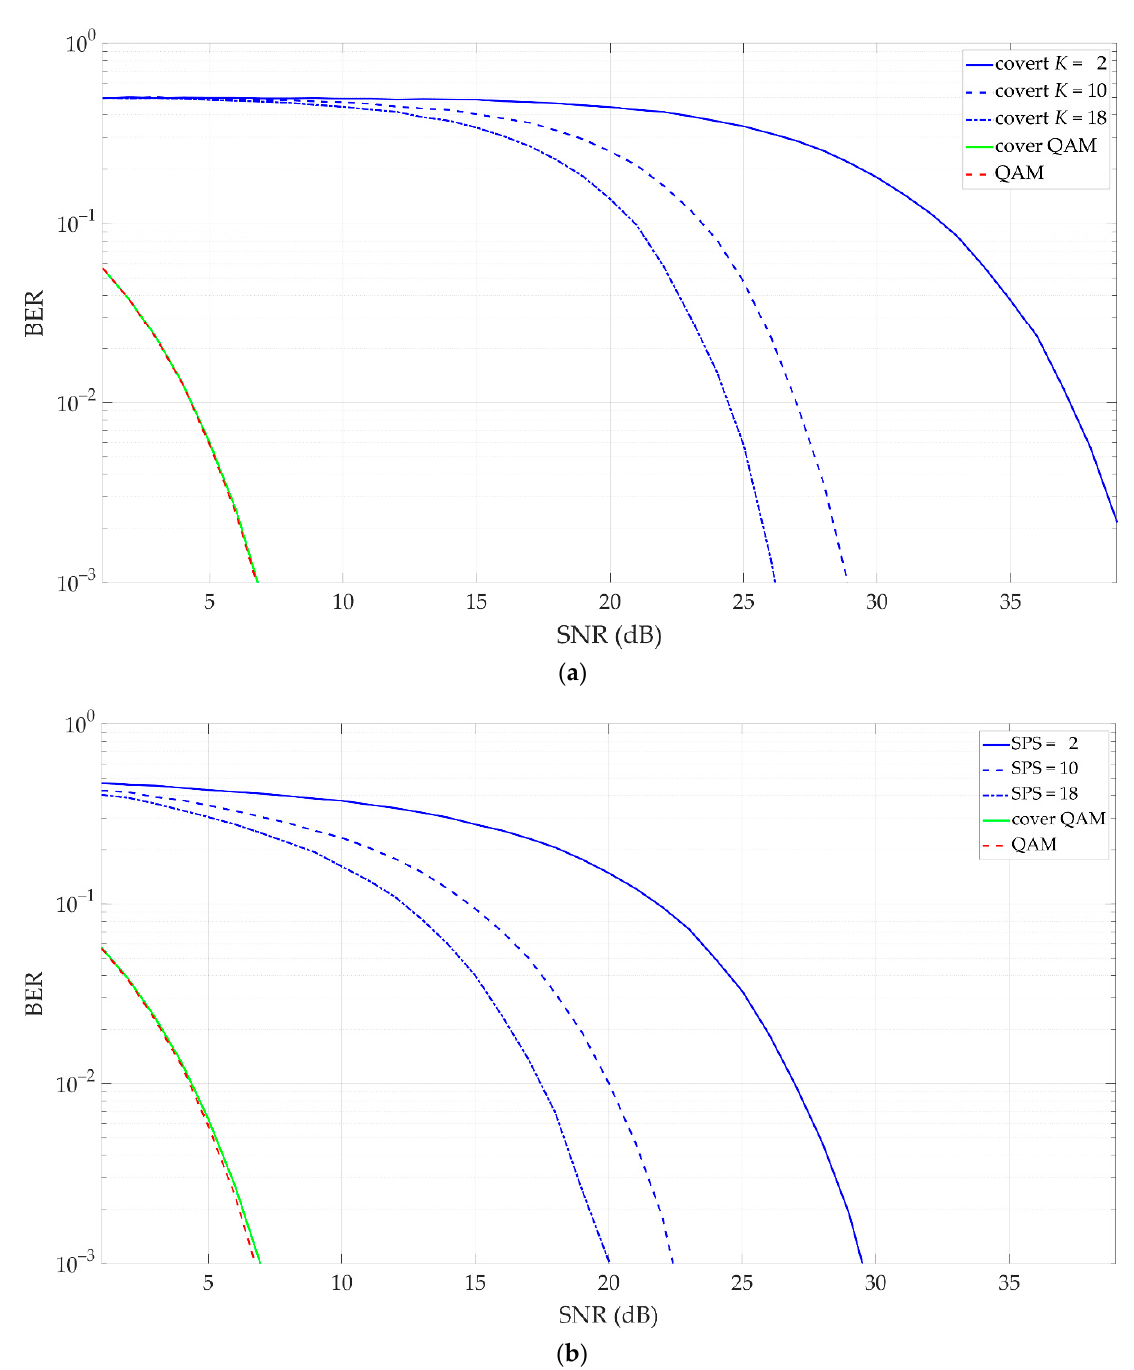
Figure 12. Comparison of dirty constellation methods based on bit error rate (BER) versus signal-to-noise ratio (SNR) graphs for EVM = 3%: ( a ) proposed solution; ( b ) solution presented in [30].